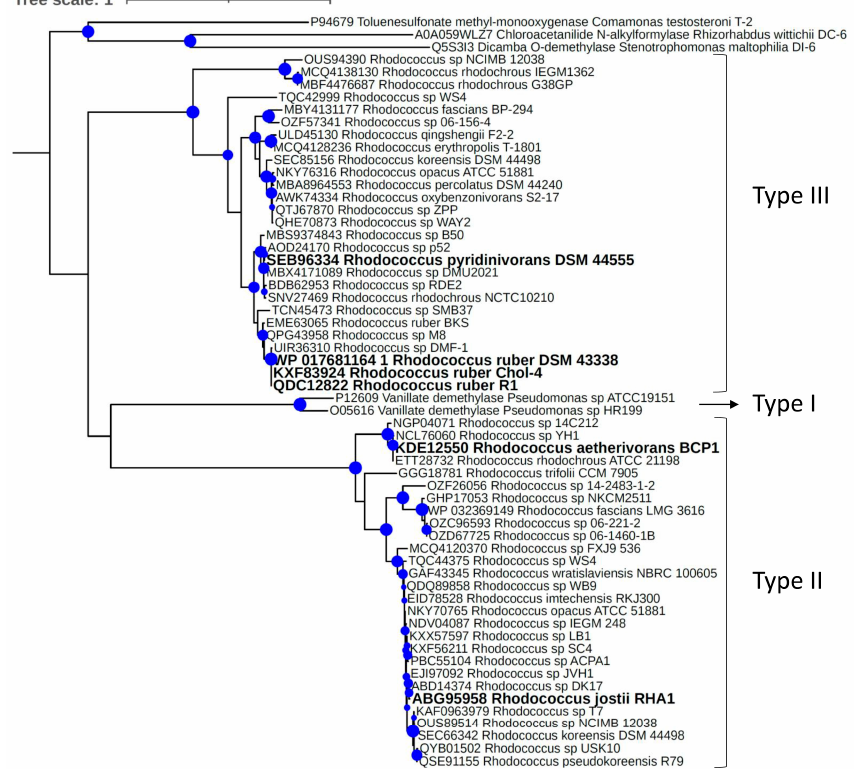
Figure 6. Evolutionary relationships among VanA homologues from Rhodococcus species. Maximum likelihood topology provided by IQ-TREE software [33] based on sequence alignments calculated using MAFFT software [36] with SH-like approximate likelihood ratio support values ( n = 1000) given at each node (values >70% are shown). VanA homologues of Pseudomonas sp. ATCC 19151 and Pseudomonas sp. HR199 were included as representatives of the proteobacterial type I VanOD. Oxygenase components of Rieske-type 4-Toluene sulfonate methyl-monooxygenase from Comamonas testosteroni T-2, Chloroacetanilide N-alkylformylase from Rhizorhabdus wittichii DC-6, and Dicamba O-demethylase from Stenotrophomonas maltophilia DI-6 were used as outgroup. Sequences highlighted in bold belong to strains tested by their ability to grow in meta -methoxylated aromatic acids as a sole carbon and energy source. 4. Conclusions Given the current interest in O-demethylation reactions for lignin conversion into renewable chemicals [54], this study aimed to shed light on Rhodococcus enzymes acting on meta -methoxylated aromatic compounds such as VA, one of the most prominent lignin- derived phenolics. This work revealed that Rhodococcus genus harbors at least two divergent types of VanOD-encoding genes represented by vanAB from Rhodococcus jostii RHA1 (Type II) and vanAB from Rhodococcus ruber R1 (Type III). Most interestingly, the VanOD from R1 strain is responsible for catabolism of additional meta -methoxylated phenolics such as 3-MB and 5-MS, as inferred from growth tests and resting cell assays of a heterologous strain expressing R1 vanAB genes, and from the substrate utilization pattern of Rhodococcus strains harboring close homologues of this enzyme. This expanded substrate specificity would be advantageous for metabolic engineering endeavors focused on bioconversion process toward renewable chemicals based on microbial demethylation of lignin monomers.